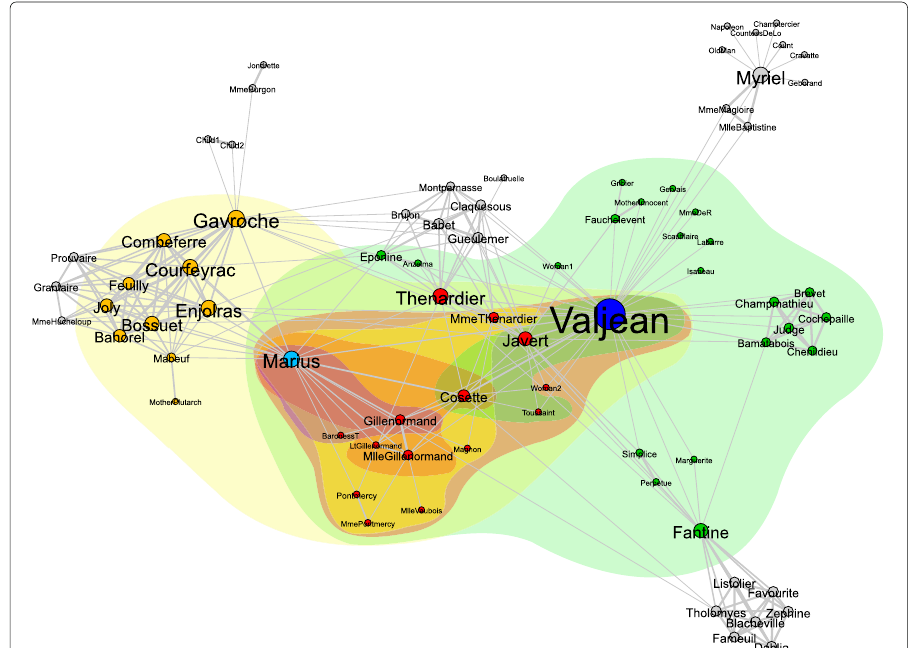
Fig. 6 Overlapping and nested zones in Les Misérables network. Two zones with Valjean (green) and Marius (yellow) egos overlap, and the other nodes of this overlap are red. The overlap nests Cosette’s zone (peach color), for which the two selected egos play the liaison role. The Cosette’s zone thus covers the entire overlap except for the Thenardier node. Further, other sub-zones nested in the overlap and in Cosette’s super-zone are marked in dark yellow, dark green, orange and violet